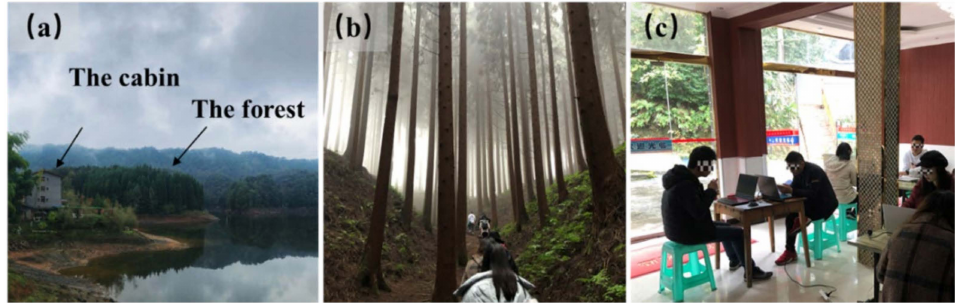
Figure 1. ( a ) The cabin in the woods, ( b ) a close view of the forest, and ( c ) the subjects who were doing the tests in the cabin.